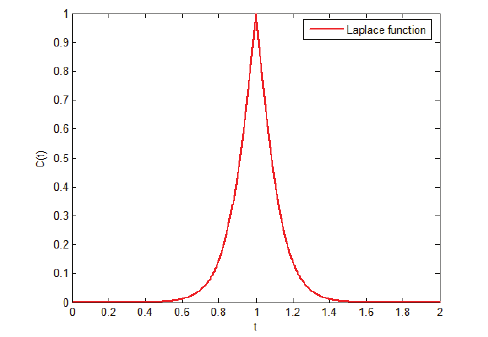
Fig. 1. The curve of Laplace fuzzy